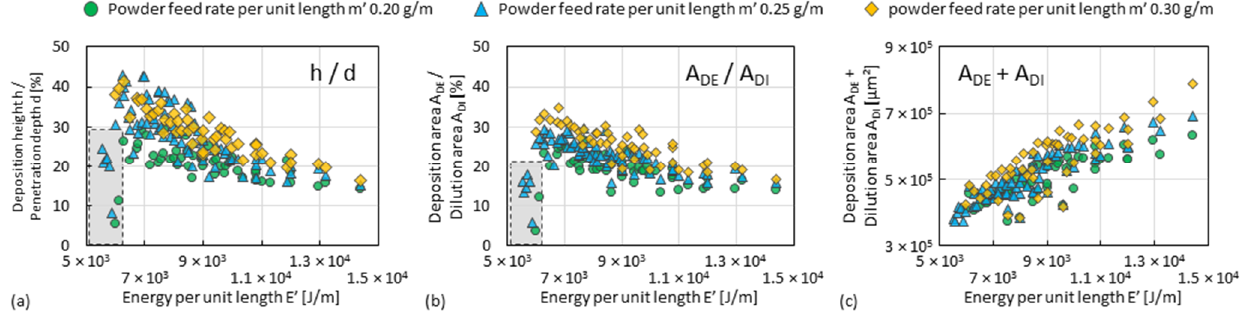
Figure 9. Plot graphs of the index ( a ) ratio of h / d , ( b ) ratio of A DE / A DI , and ( c ) sum of A DE + A DI against E’ . Every point refers to the average value of three measurements.